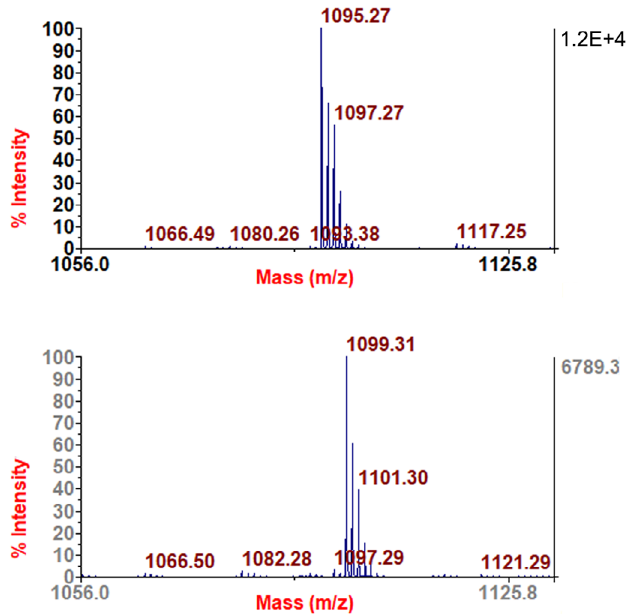
Figure 2. Determination of the cysteine number in the investigated native conopeptide p2.4.2 (upper graph) and in its reduced form by TCEP (lower graph) from off-line LC MALDI-TOF MS. Note the shift of 4 Da characterizing the reduction of two disulfide bonds.